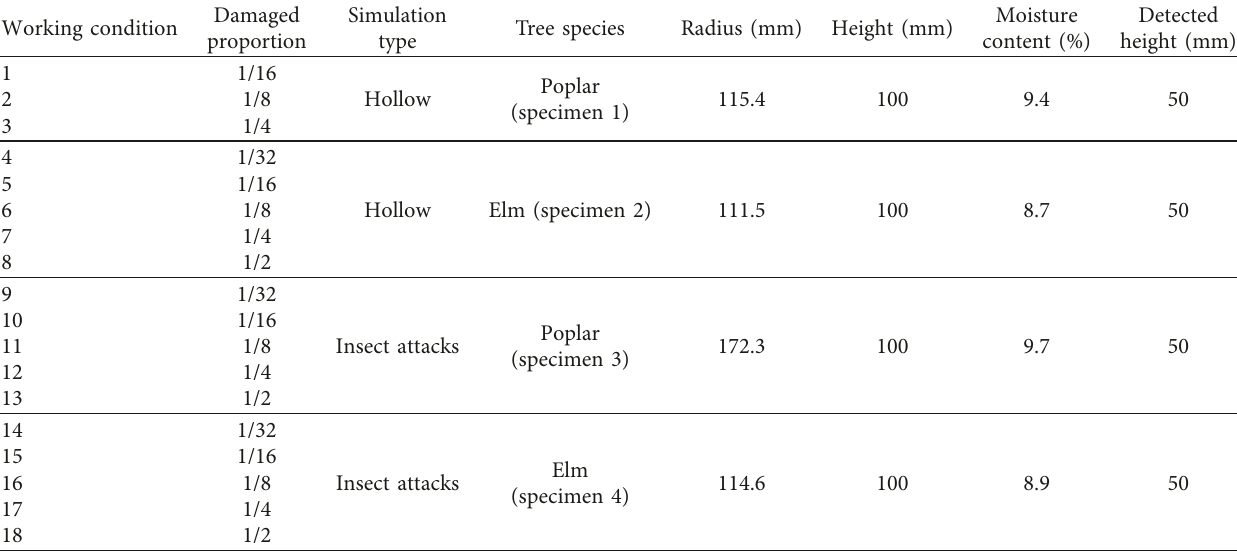
Table 1: Parameters of test specimens.